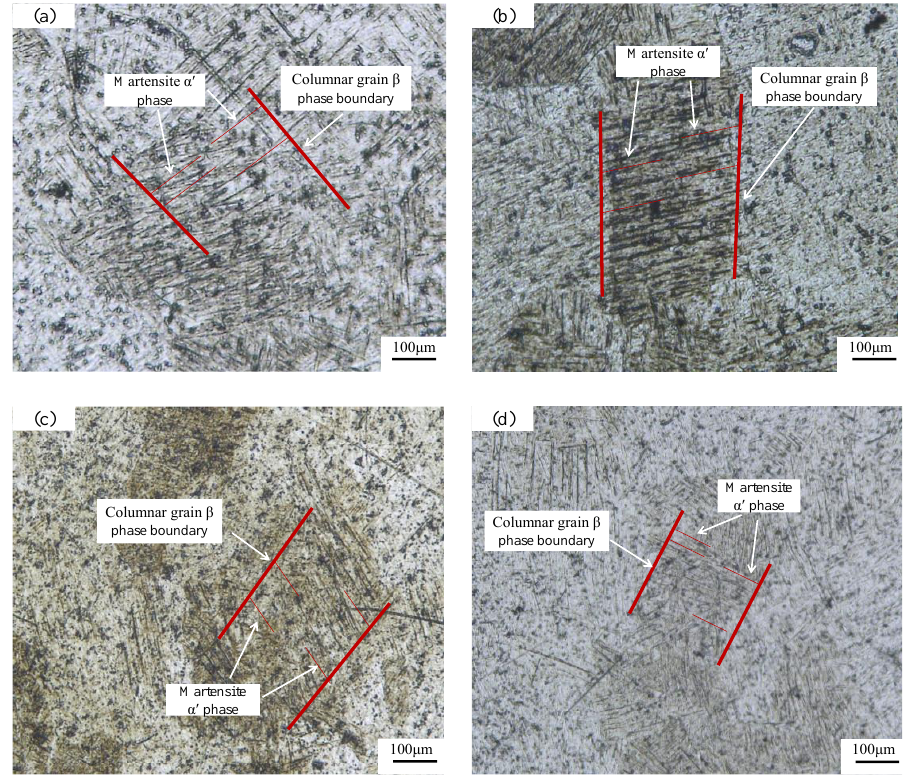
Figure 11. Metallographic structure. ( a ) 2#; ( b ) 11#; ( c ) 10#; ( d ) 9#. Figure 12. Metallographic structure. ( a ) 2#; ( b ) 11#; ( c ) 10#; ( d )